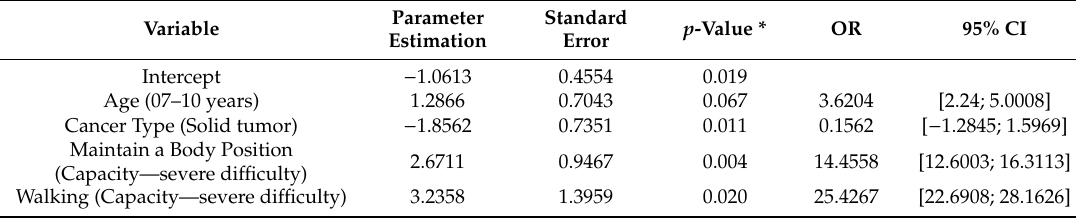
Table 4. Significant variables in the final logistic regression